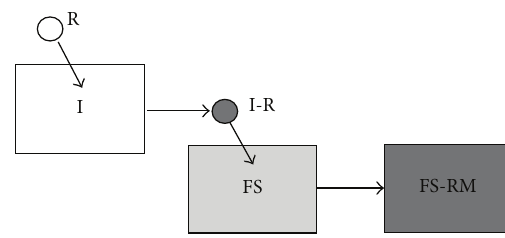
Figure 7: Schematic diagram of stepping scheme for multiphase double inclusion problem.